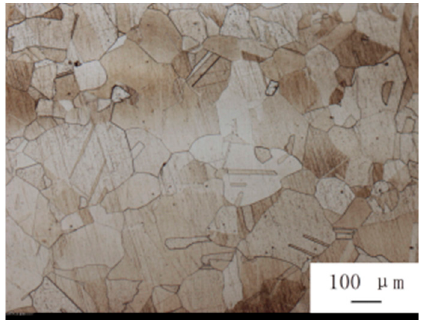
Figure 7. Original morphology of Nb-contained 316LN.